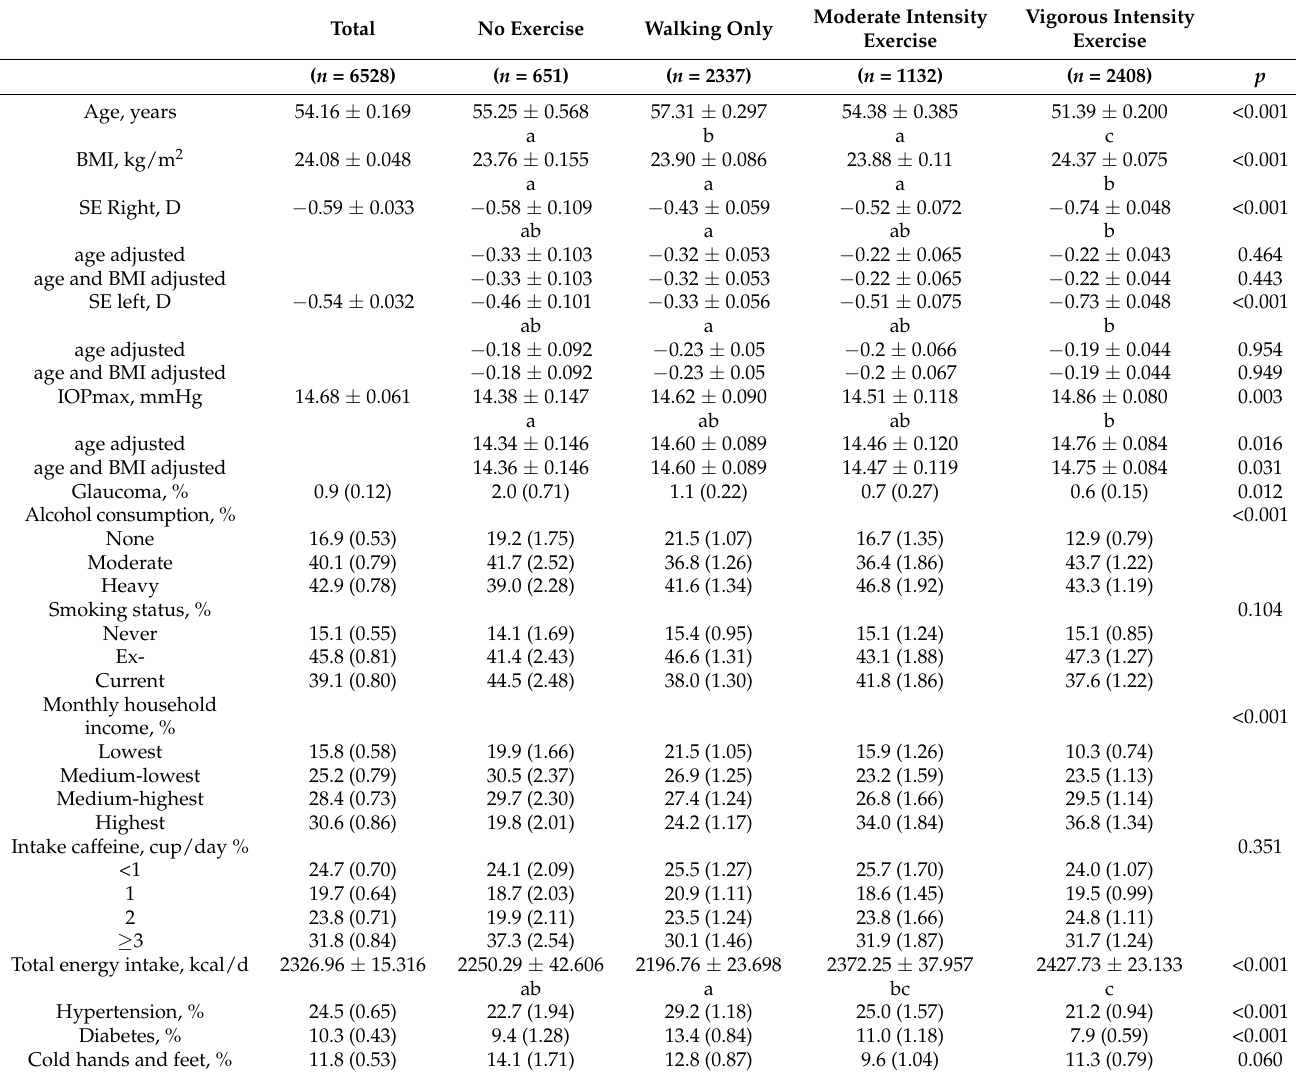
Table 1. Baseline characteristics of study